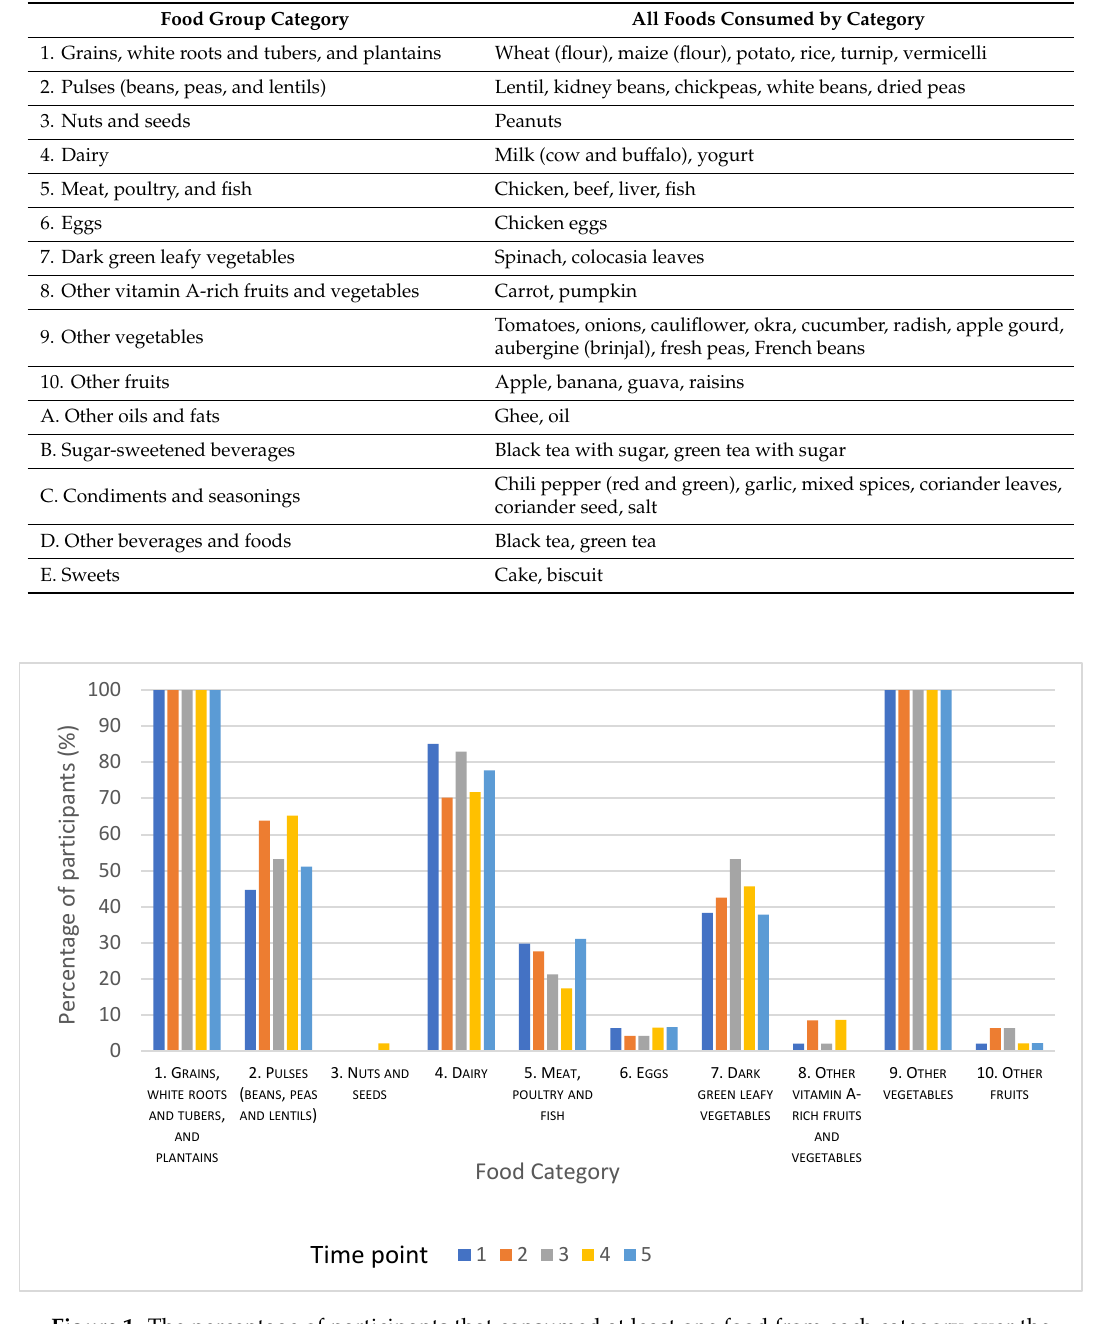
Figure 1. The percentage of participants that consumed at least one food from each category over the five study time points.